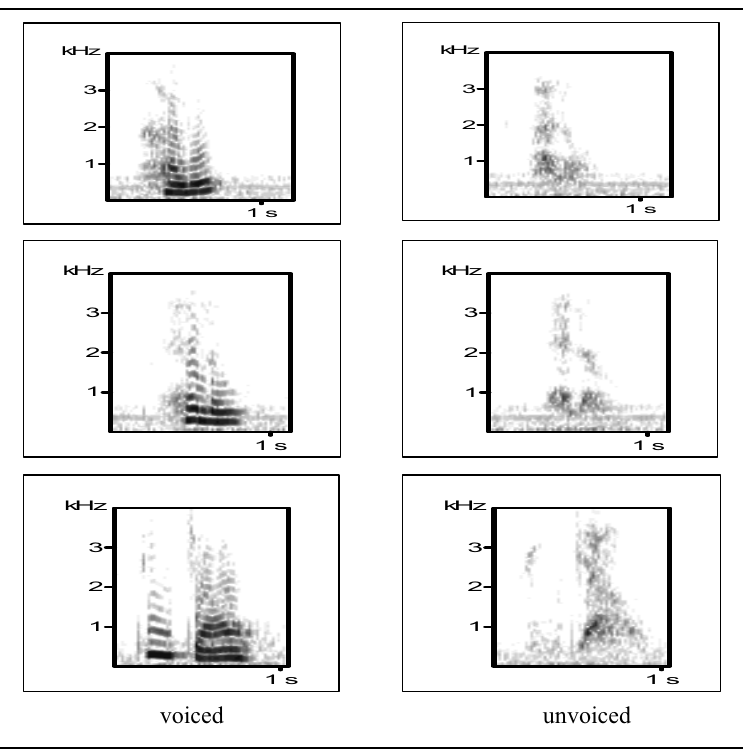
Fig. 1 – Frequency spectrograms of words spoken either in a normal (= voiced, phonated) manner (left) or in a whispered (= unvoiced) manner (right). Top: Ger- man expression of the word ‘hallo’. Middle: English expression of the word ‘hallo’. Bottom: Expression of ‘xin chao’, i.e. a Vietnamese equivalent of